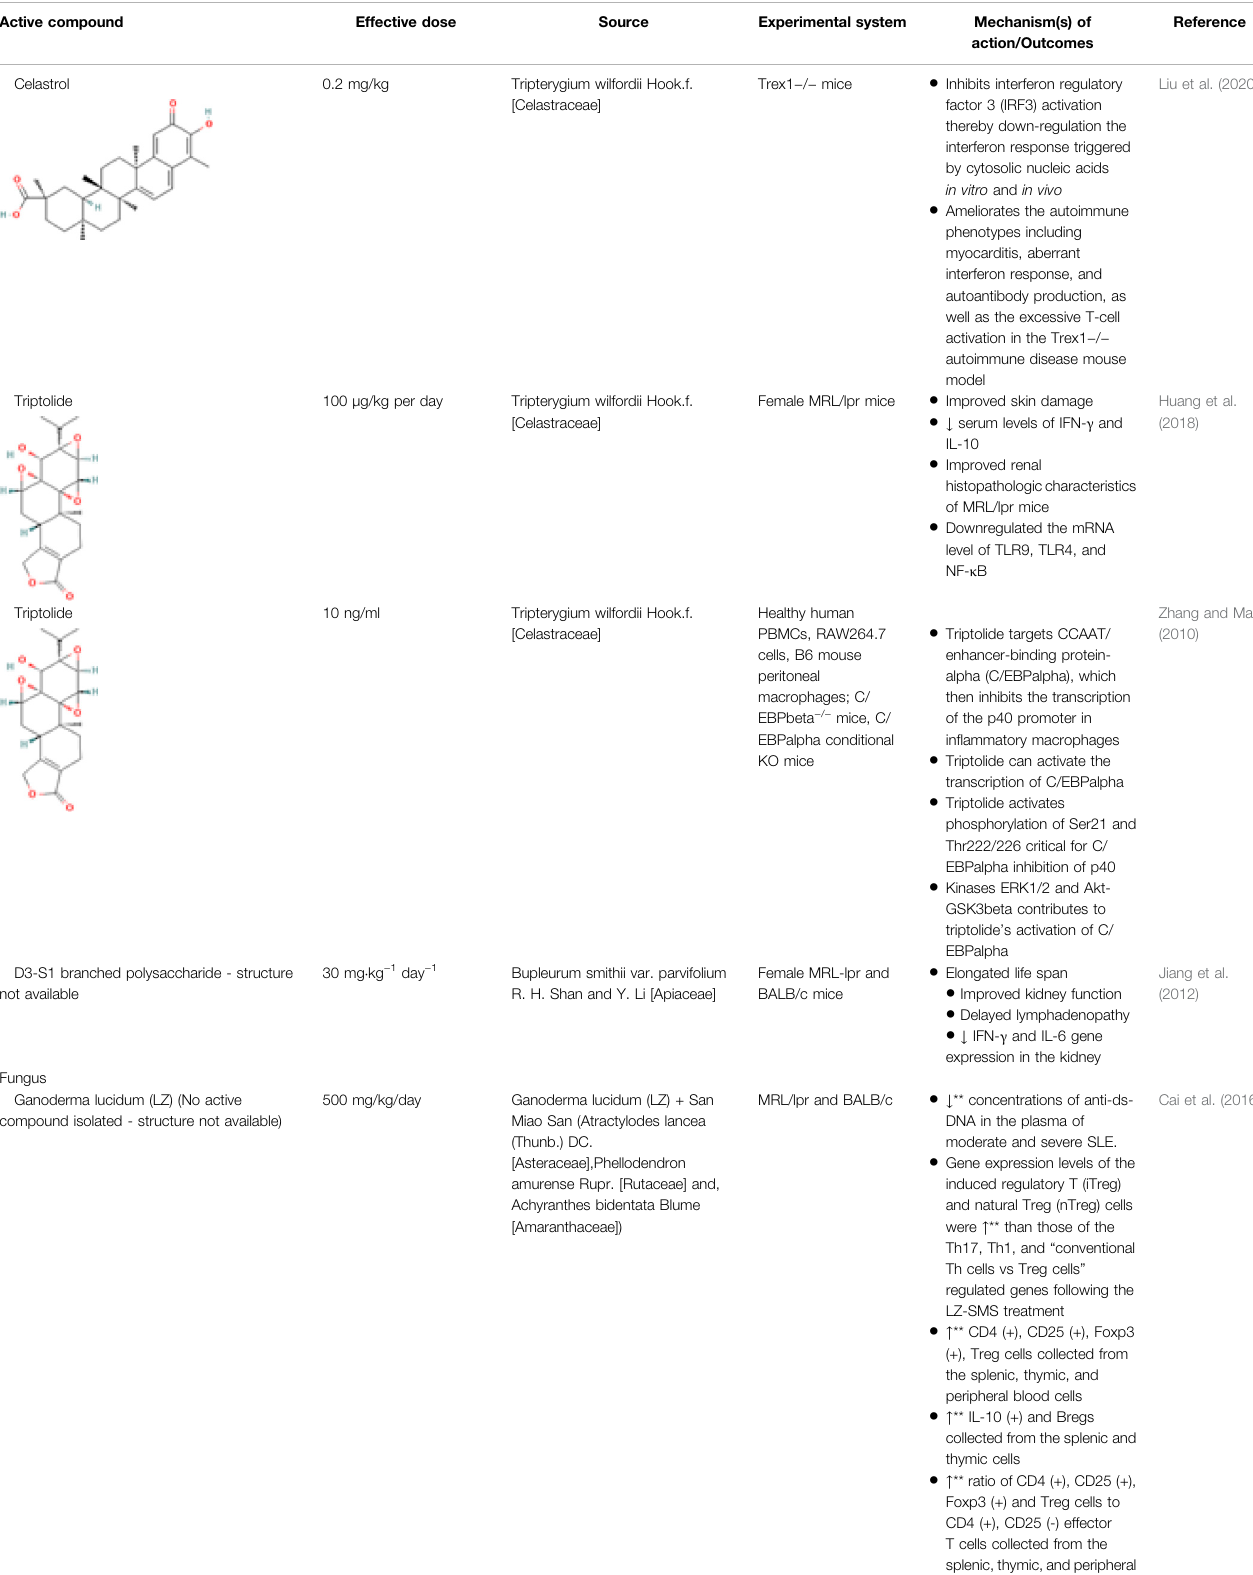
TABLE 1 | ( Continued ) Synthesized fi ndings for potential bioactive compounds for